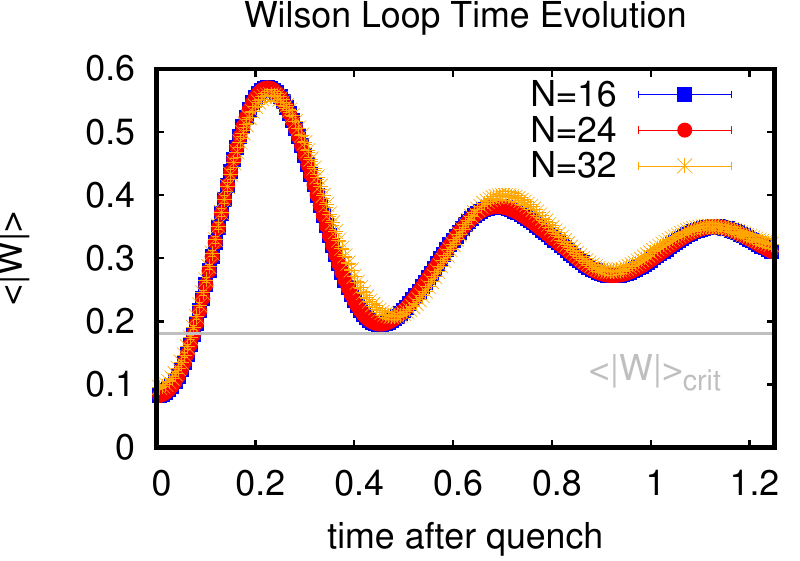
Figure 8 . Time evolution of Wilson loop expectation value after a quench from E=N 2 = 1200 to E=N 2 = 500 for various N . Grey line indicates critical value of Wilson loop, eq.